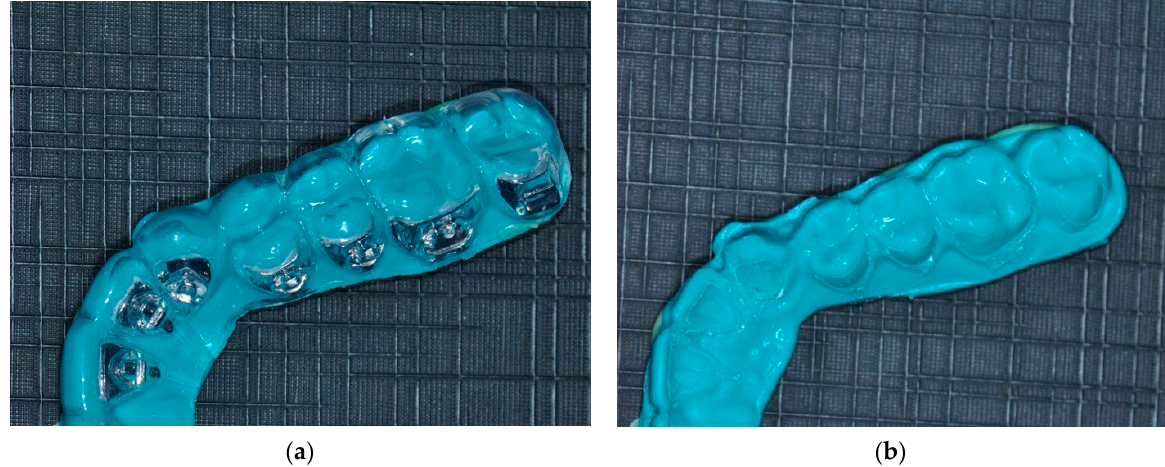
Figure 1. Etching guide preparation: ( a ) light-body poly-vinyl siloxane dental impression material placed inside the indirect bonding transfer tray; ( b ) impression of the inner surface of the indirect bonding tray.